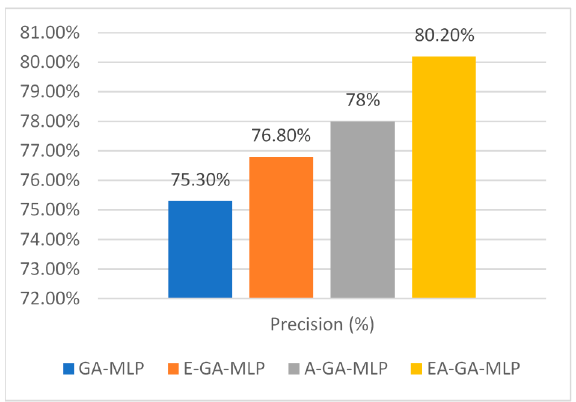
Figure 7. Comparative analysis of Precision of presented Algorithm EAGA with its subcomponents.